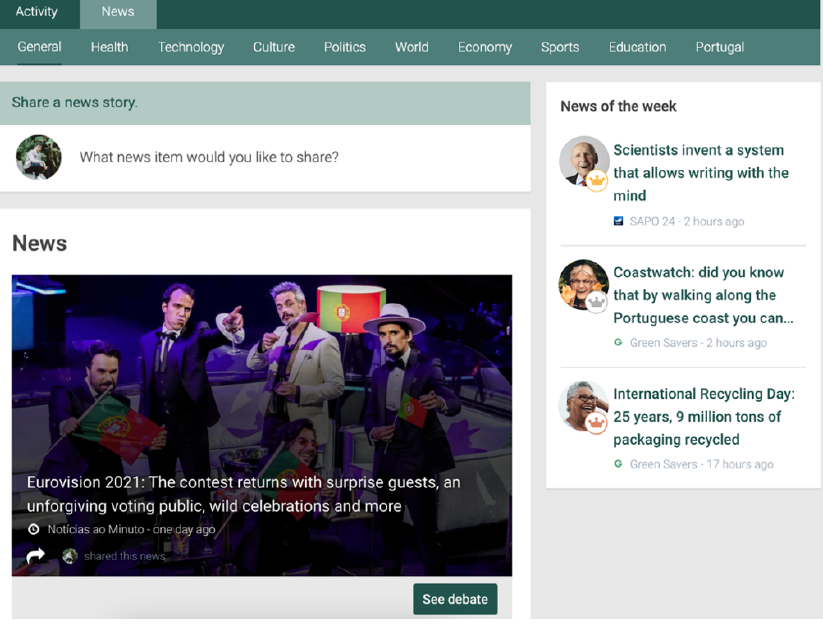
Figure 8. Leaderboard scheme (Authors’ copyright).